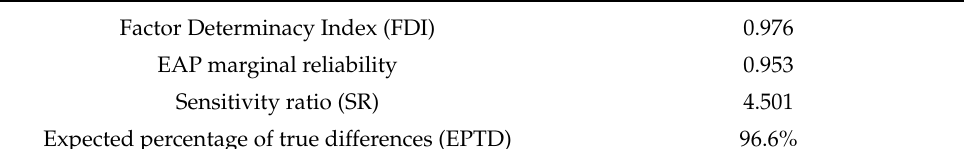
Table 2. Quality and effectiveness of factor score estimates.